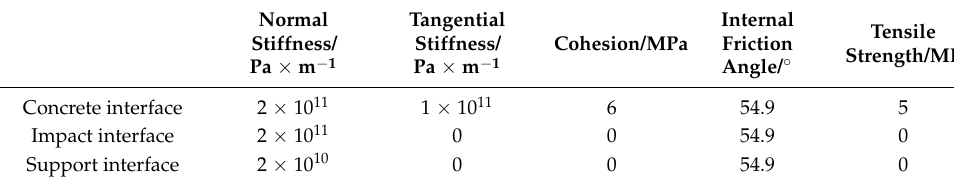
Table 2. Constitutive parameters of contact